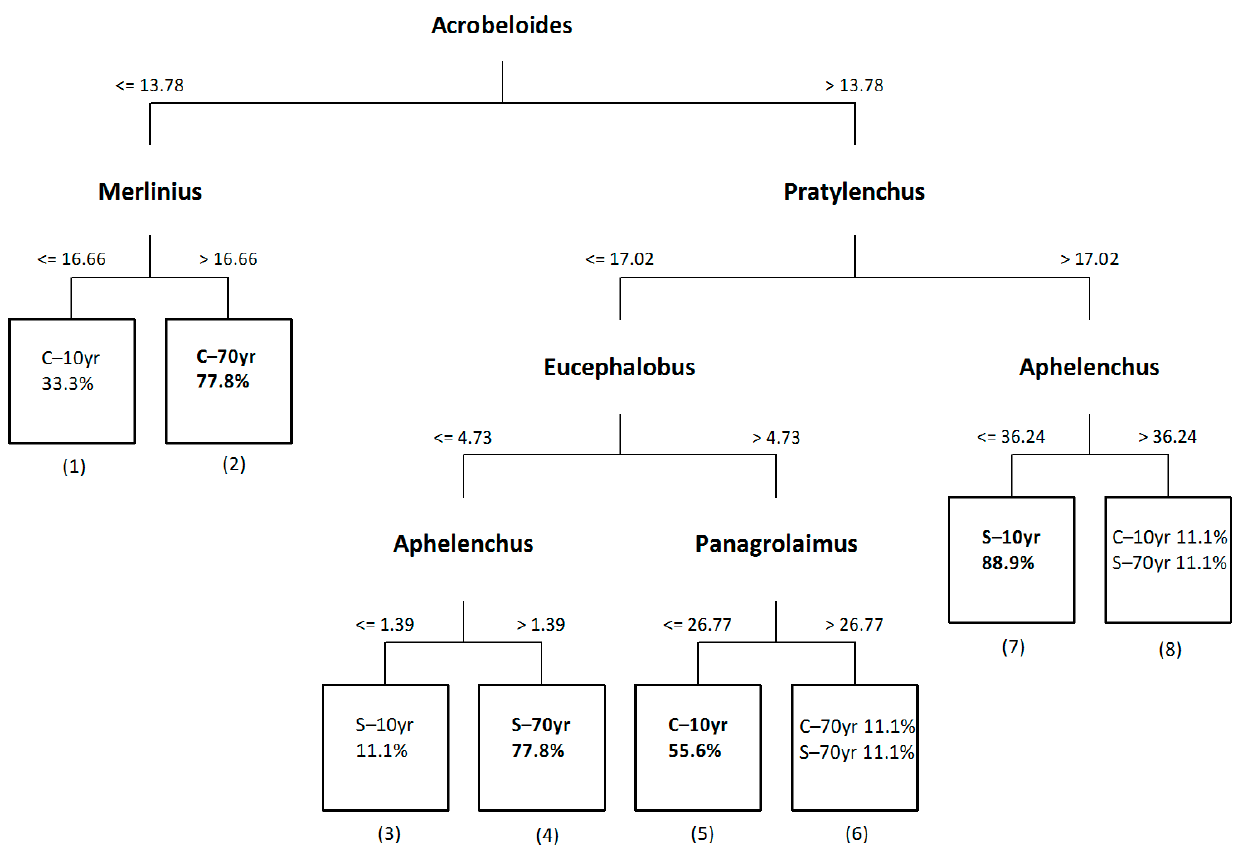
Figure 3. Classification tree based on nematode genera abundance (individuals/100 g dry soil) in the rhizospheres of the alien Solanum elaeagnifolium (S) and the native Cichorium intybus (C) in recently (10yr) and historically (70yr) invaded sites. The percentage of correct classification of samples in each node is indicated. Numbers are assigned to all terminal nodes. Pure terminal nodes are indicated in bold.